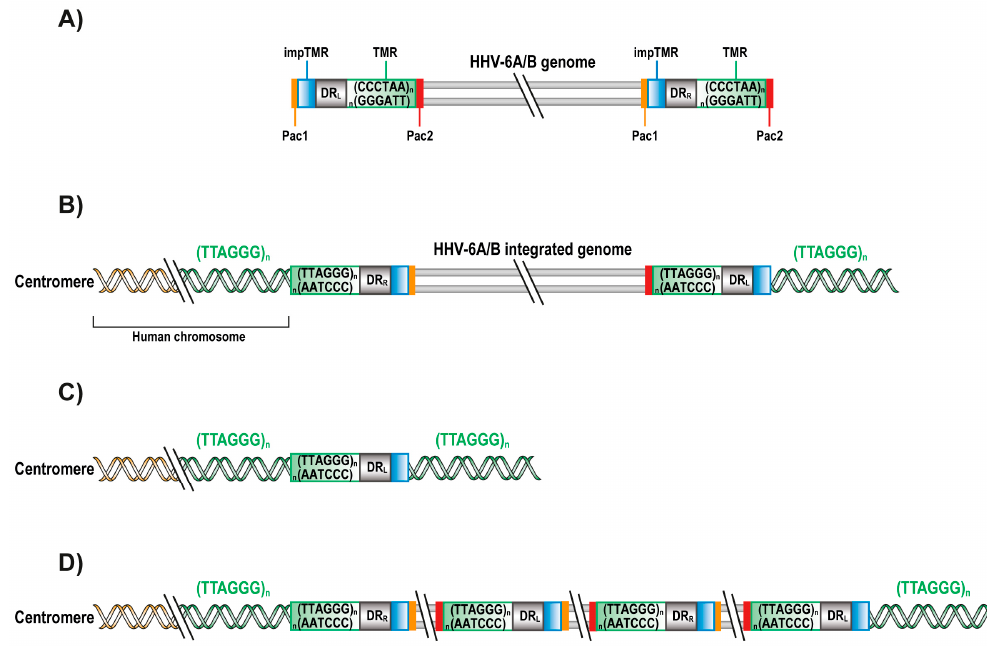
Figure 1. HHV-6A/B genomes and their integrated forms. Schematic representation of human herpesvirus 6A and 6B (HHV-6A/B) genomes and the reported integrated forms. ( A ) The unique region (U) of the 160 kbp HHV-6A/B genomes is flanked by identical direct repeats (DR L and DR R ) of 8–9 kbp. The DRs possess a pac1 (yellow) and pac2 (red) sequences, adjacent to imperfect telomeric repeats impTMR (blue) and TMR (green) sequences, respectively. The genome is not drawn to scale; ( B ) Chromosomally integrated HHV-6A/B (ciHHV-6A/B) genome (with loss of pac2 in DR R and pac1 in DR L ) with elongated telomeres at the DR L ; ( C ) Single integrated DR L with elongated telomere; ( D ) Integrated HHV-6A/B concatemers. Genomes are not drawn to scale.